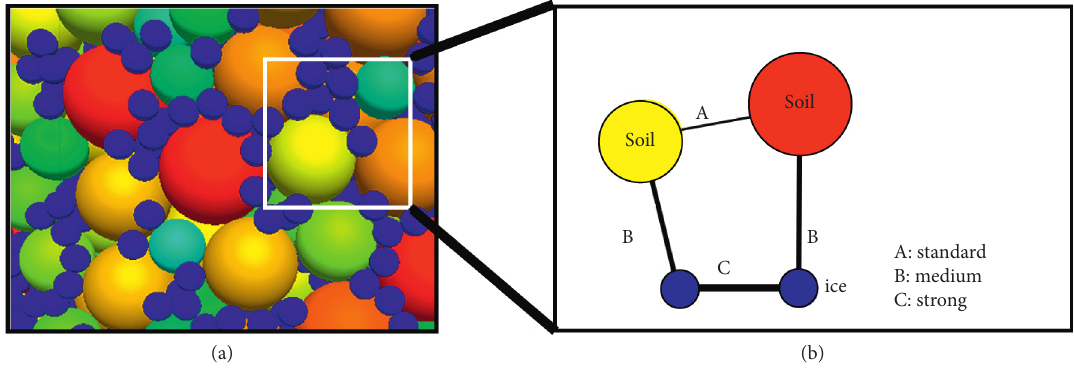
Figure 5: Contacts in the soil Table 2: Main mesoscopic parameters.